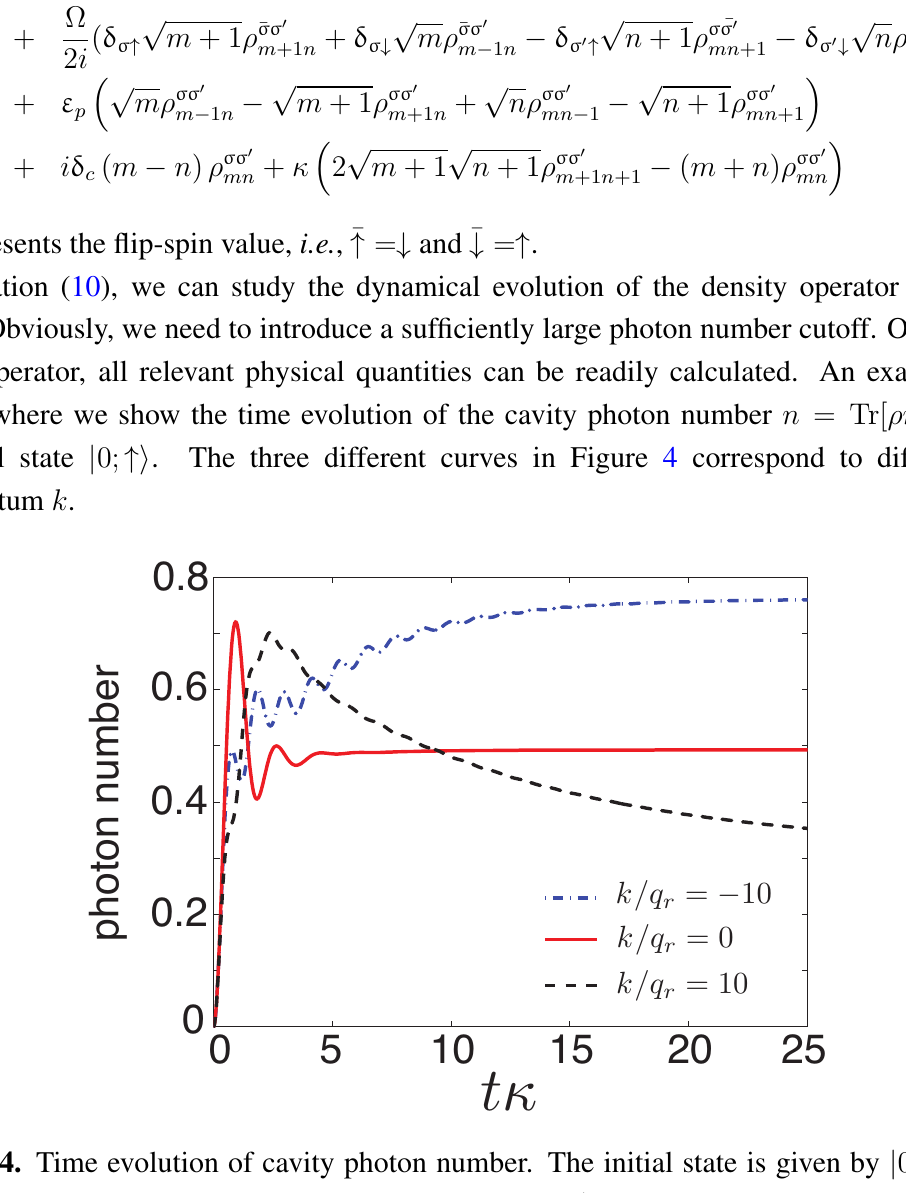
Figure 4. Time evolution of cavity photon number. The initial state is given by we consider the same parameter as in Figure 5a with k/q values, obtained in the long time limit as shown here, correspond to red dashed lines at corresponding k values in Figure